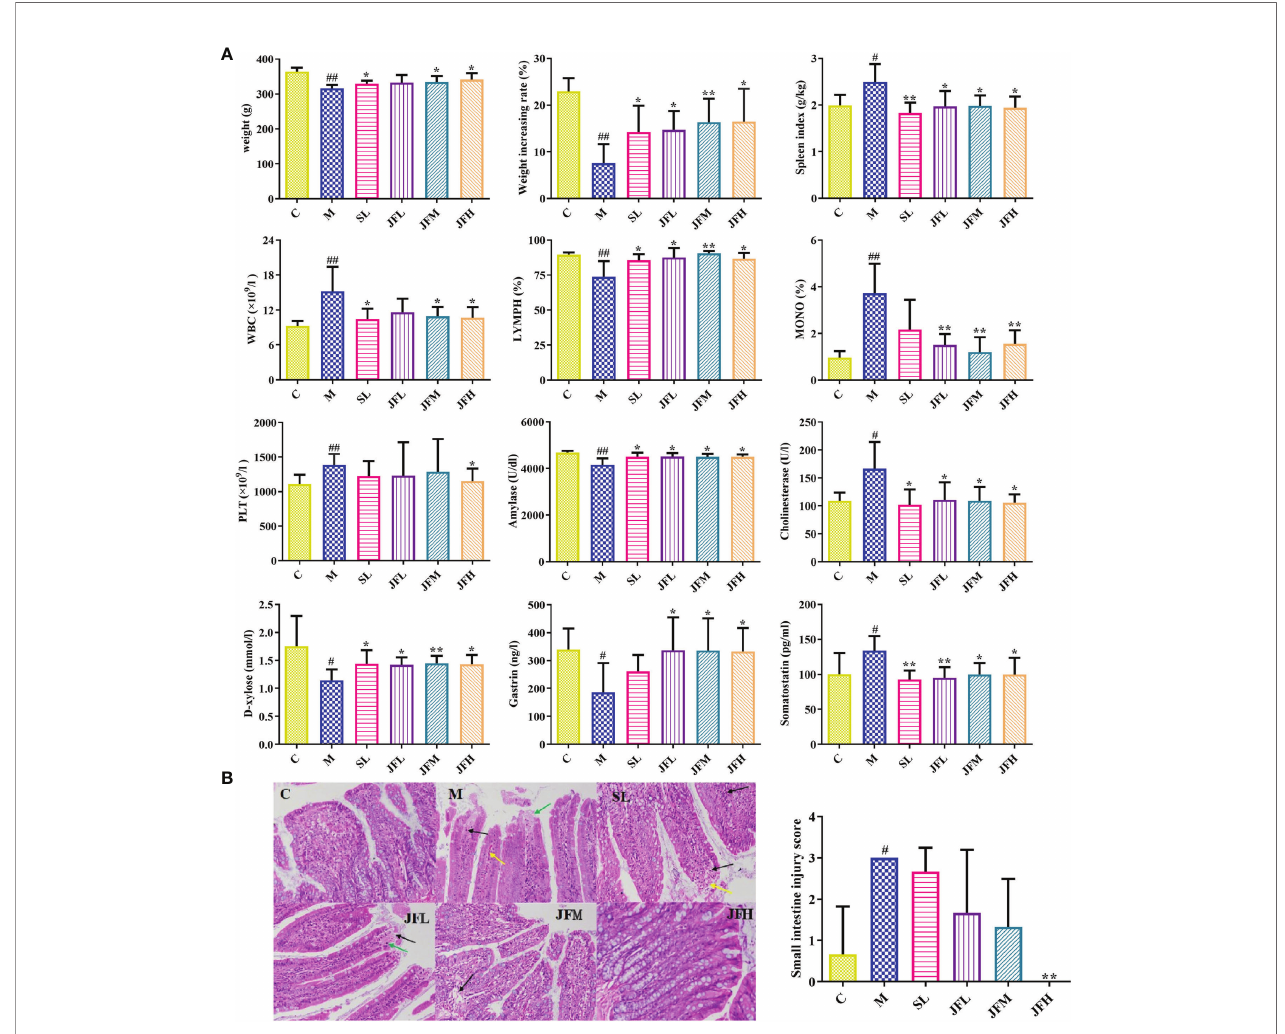
FIGURE 1 | Determination of appearance indicator, peripheral blood routine and biochemical indicators (A) ; pathological sections of small intestine HE staining (B) . WBC: white blood cell count; LYMPH: lymphocyte ratio; MONO: monocytes ratio; PLT: platelet count. (C) control group; (M) model group; (SL) positive group; (JFL) low dose group of JF extract; (JFM) medium dose group of JF extract; (JFH) high dose group of JF extract. Data are expressed as means ± SD, n = 6. # P < 0.05, ## P < 0.01: model vs control; *P < 0.05, **P < 0.01: treatment vs